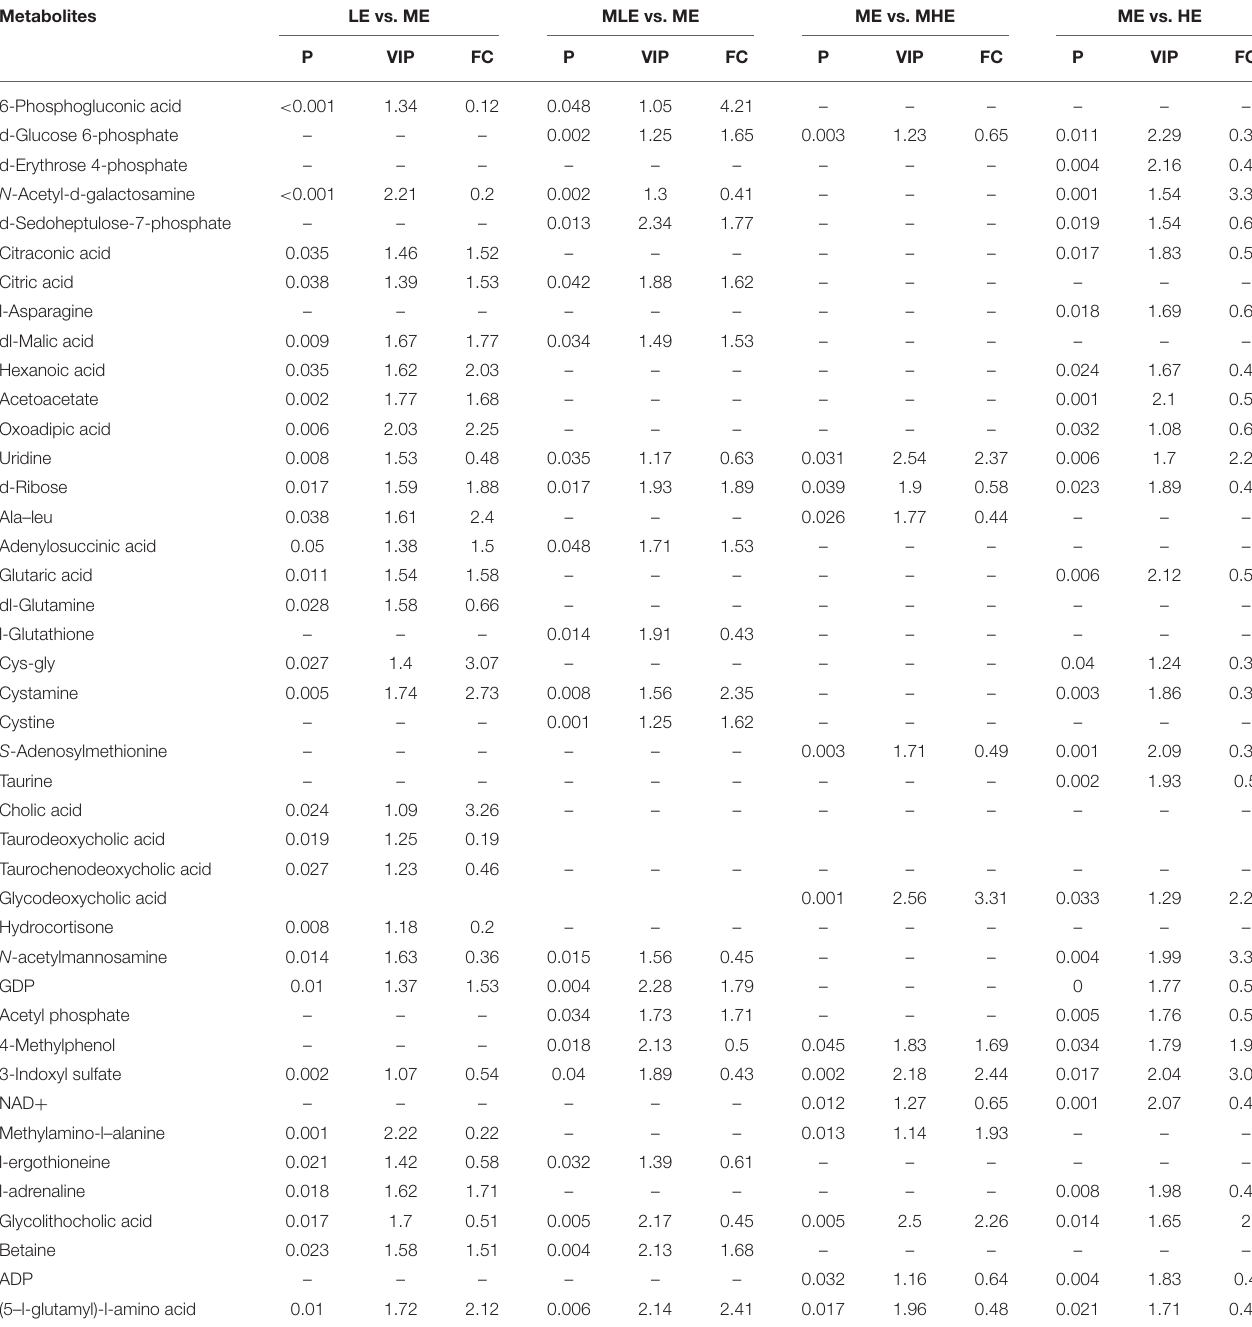
TABLE 4 | Identification of different metabolites in the